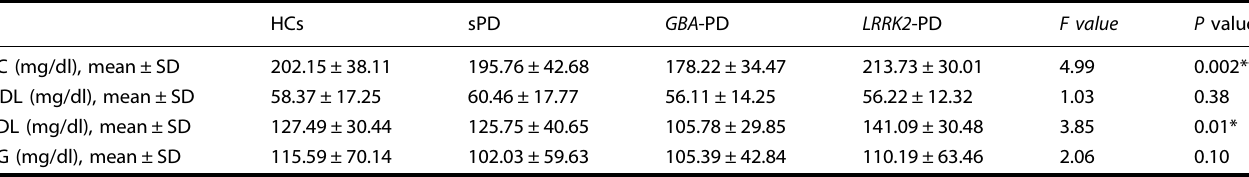
Table 3. Serum lipid pro fi le in healthy controls and Parkinson ’ s disease